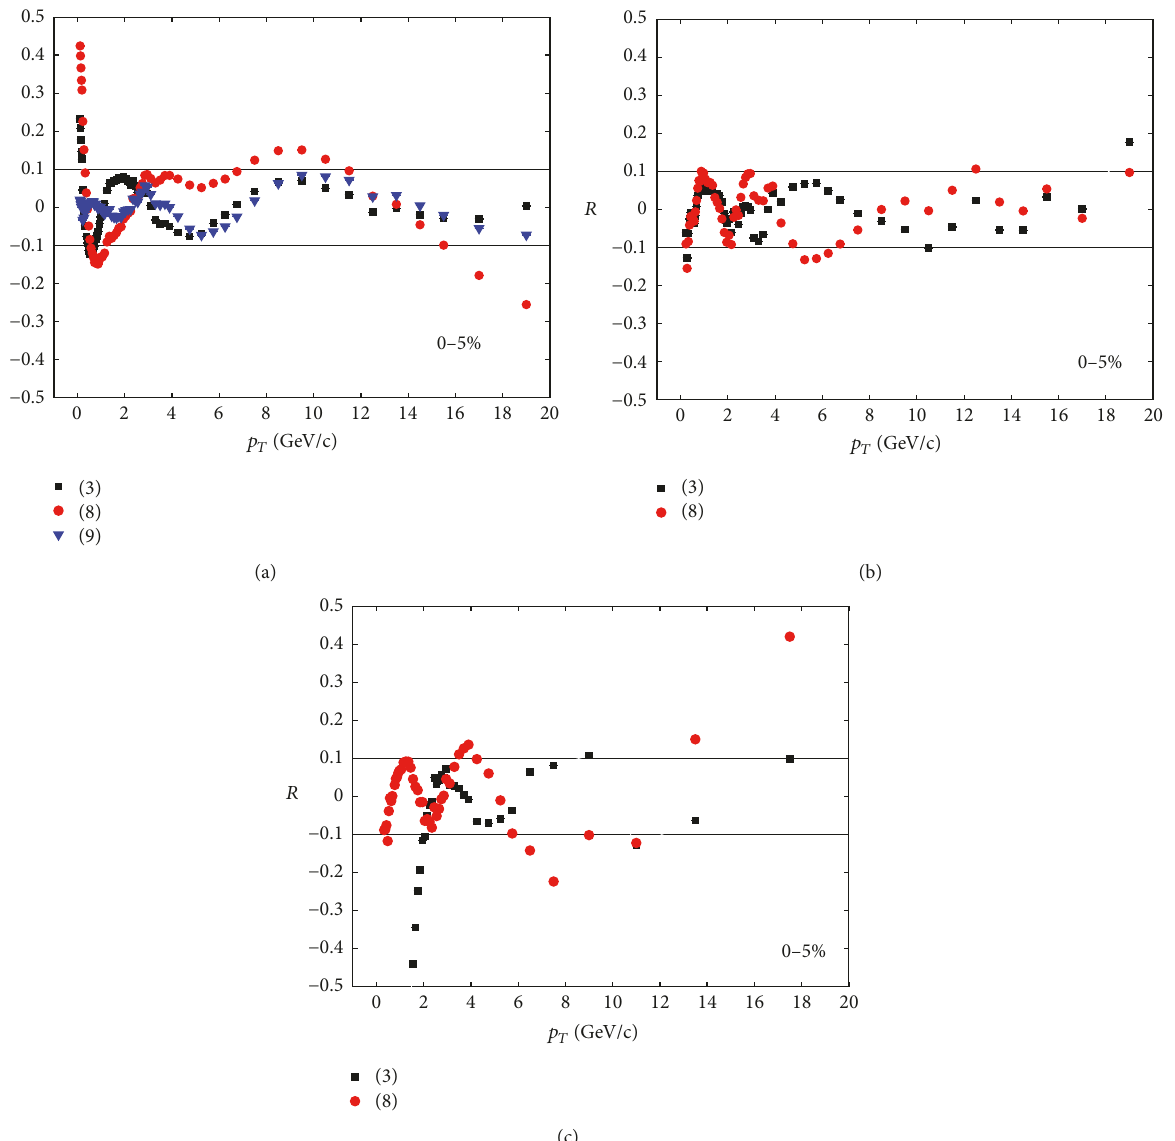
Figure 4: The relative discrepancies of (3), (8), and (9) from the 𝑝 𝑇 spectra for (a) 𝜋 + + 𝜋 − , (b) 𝐾 + + 𝐾 − , and (c) 𝑝 + 𝑝 at centrality 0–5% shown in Figures 1, 2, and 3,